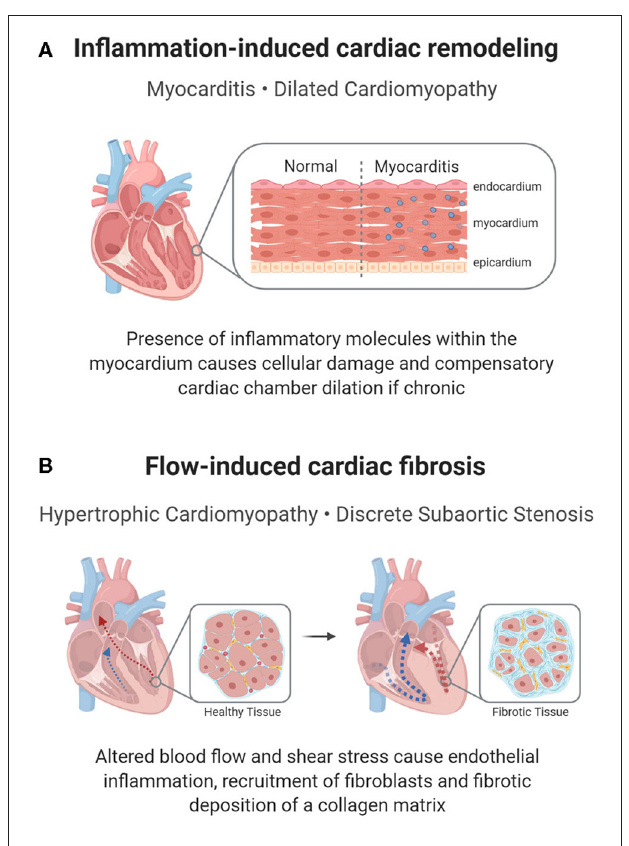
FIGURE 3 | Inflammation-mediated pediatric cardiac disease. In addition to a cellular response, a molecular inflammatory response can lead to pediatric heart disease or its complications. (A) In myocarditis, inflammation of the cardiac muscle can cause reactionary remodeling, in some cases leading to DCM. (B) Remodeling can also be seen in shear stress induced inflammation, which propagates a pro-fibrotic environment in HCM or